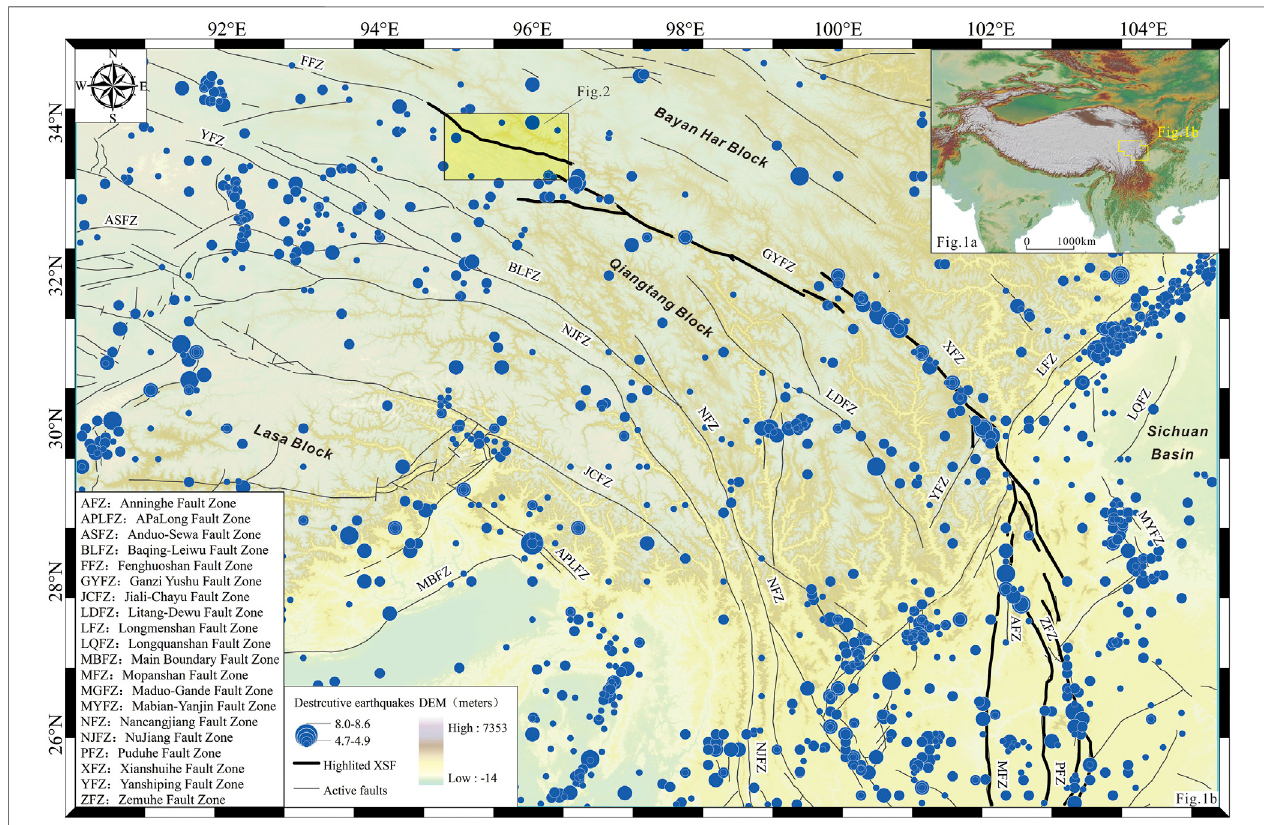
FIGURE 1 | Sketch map of earthquake distribution and geological background of the study area. (A) Topographic relief of the Tibet Plateau. (B) Seismotectonic map of the Xianshuihe Fault Zone (XFZ) and the surrounding area. Black bold lines in the map represent the XFZ structure. Blue solid circles represent the destructive earthquake epicenters ( M s ≥ 4.7, epicenters are from the China Earthquake Networks Center, 2020). Red solid lines represent the main active fault traces (Deng et al., 2007). The light yellow rectangle on the north side of the image represents the scope of the study region. The inset at the lower left shows the abbreviation of regional active faults illustrated in the